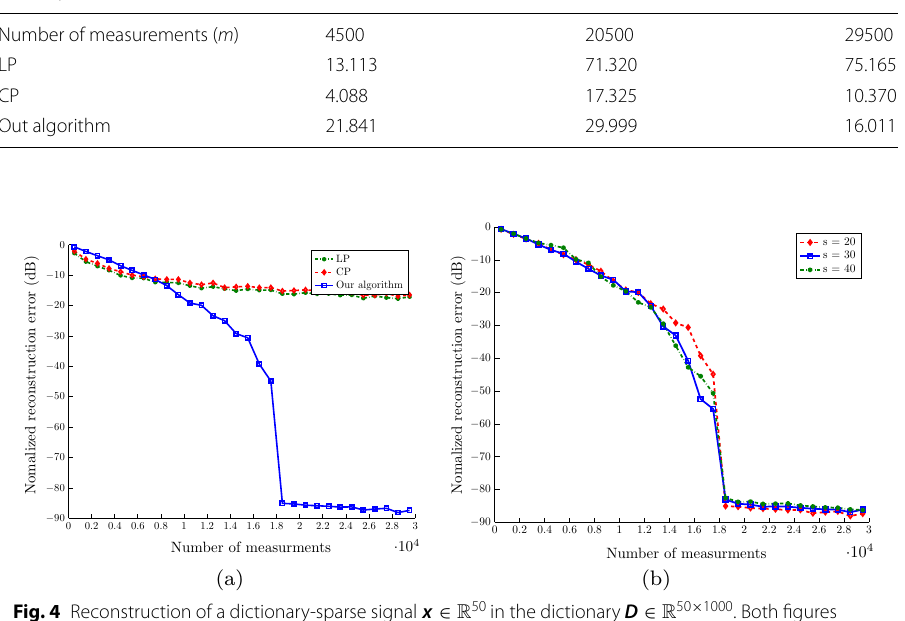
Fig. 4 Reconstruction of a dictionary-sparse signal x show the reconstruction error averaged over 100 Monte Carlo simulations. Image a compares the performance of the algorithms in s sparsity